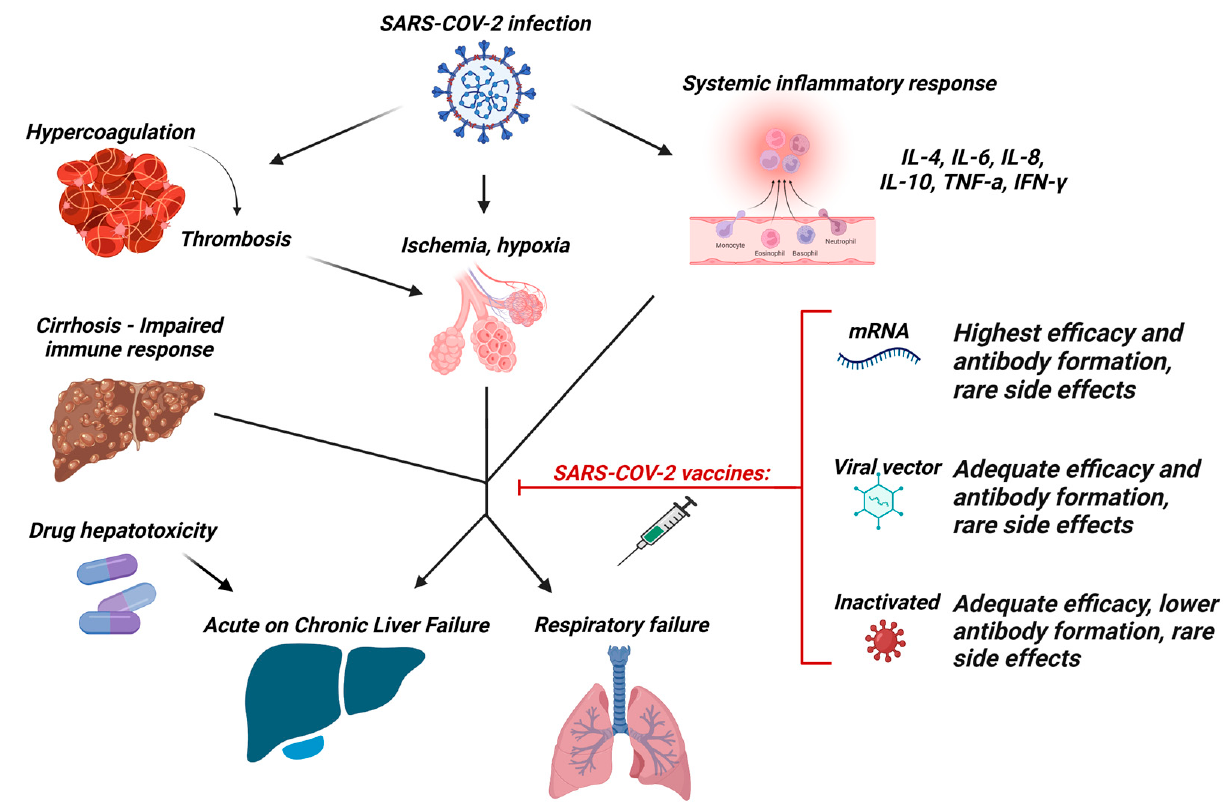
Figure 1. Mechanisms of liver and lung injury caused by SARS-CoV-2 infection in patients with cirrhosis and efficacy of commonly used vaccines. Abbreviations: IL: Interleukin; SARS-CoV-2: Severe acute respiratory syndrome coronavirus 2. Created with BioRender.com. Used under license nr VA24ZJX03J.